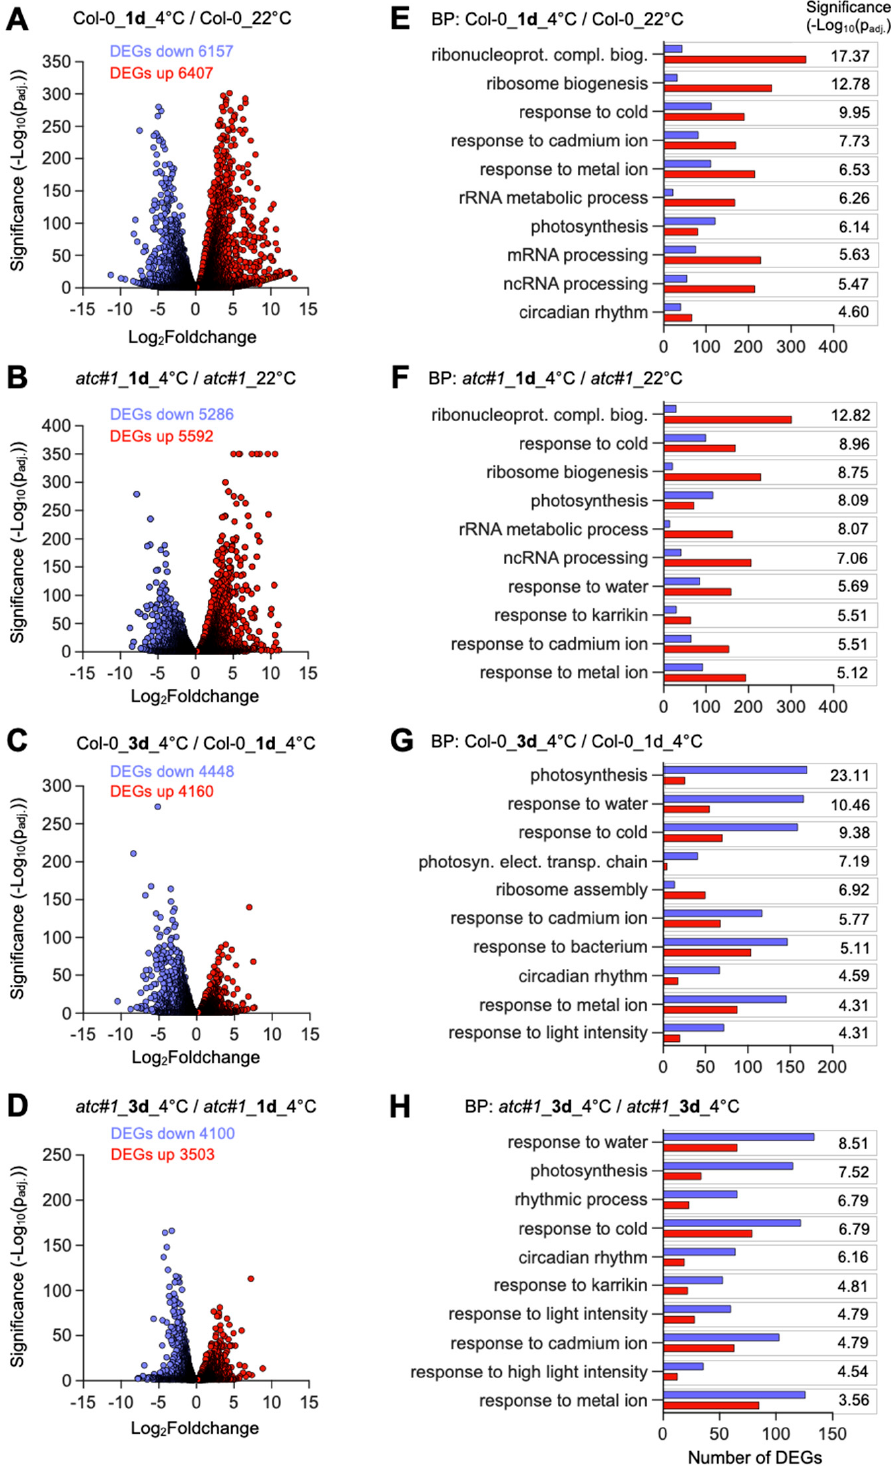
Figure 3. Global transcript alterations in Col-0 and atc#1 mutants during cold acclimation. Plants were grown for six weeks at 22 °C before being transferred to 4 °C for one or three days. ( A – D ) Volcano plots show differentially expressed genes (DEGs) (p adj. < 0.05) in Col-0 ( A , C ) and atc#1 mutants ( B , D ) comparing one day in the cold to the control ( A , B ) and three days of the cold to one day of the cold treatment ( C , D ). All listed DEGs were used for ( E – H ) GO-Term analysis, revealing significantly altered biological processes (up-regulated in red and down-regulated in blue color). A category only appearing in the top 10 list in atc#1 (one day and three days of cold) is “response to Karrikin,” a compound synthesized during wildfire. Upregulated genes in this category belong to sugar metabolism, photosynthesis, chaperones, and transcription factors.